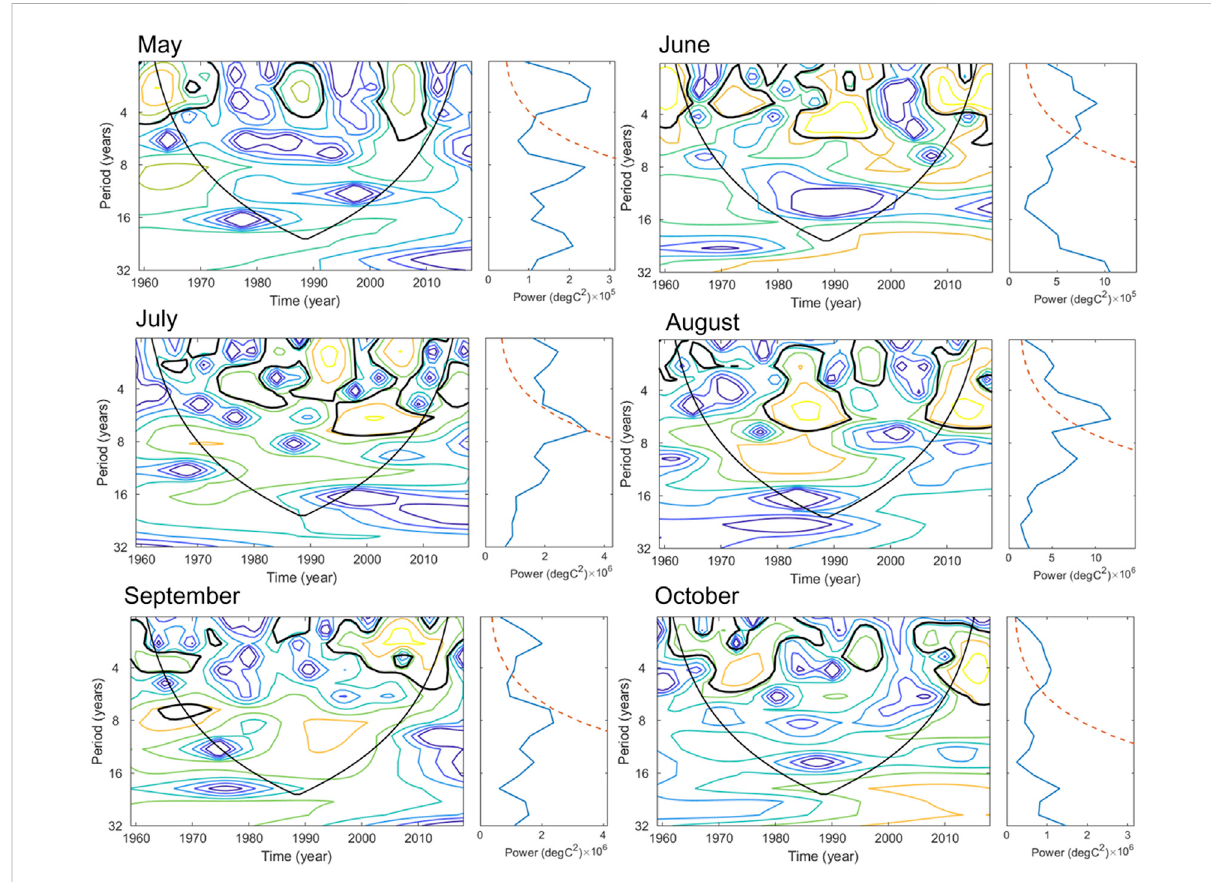
FIGURE 10 Wavelet power spectrum and global wavelet spectrum of monthly TCP over China from 1959 to